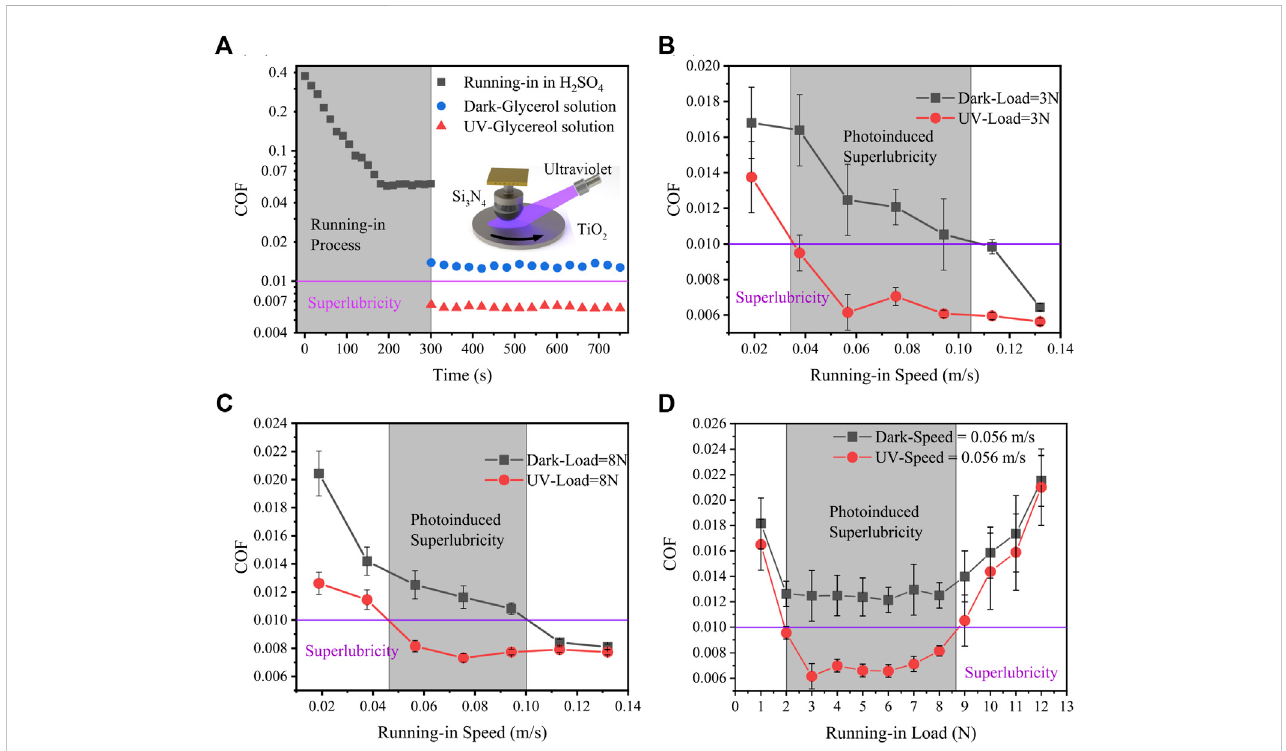
FIGURE 1 (A) Superlubricitywasachieved(COF=0.0062)in70%glycerolaqueoussolutionafterrunning-ininH 2 SO 4 solution(pH=1,blacksquare)withultraviolet illumination (red triangle), while ordinary lubrication was achieved without ultraviolet illumination (blue circle). (B) When the load was 3 N, the friction coef fi cientschangedwiththeincreaseintherunning-inspeeds.Photoinducedsuperlubricitywasachievedataspeedfrom0.035 m/sto0.105 m/s. (C) When the load was 8 N, photoinduced superlubricity was achieved at a speed from 0.045 m/s to 0.100 m/s. (D) When the speed was 0.056 m/s, the friction coef fi cients changed with the increase in the running-in loads. Photoinduced superlubricity was achieved under a load from 2 N to 8